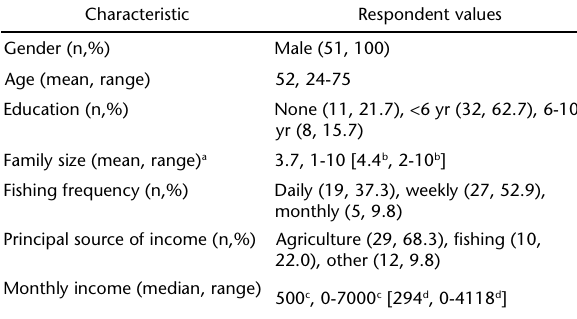
Table II. Respondent profile. Characteristics of the 51 respondents